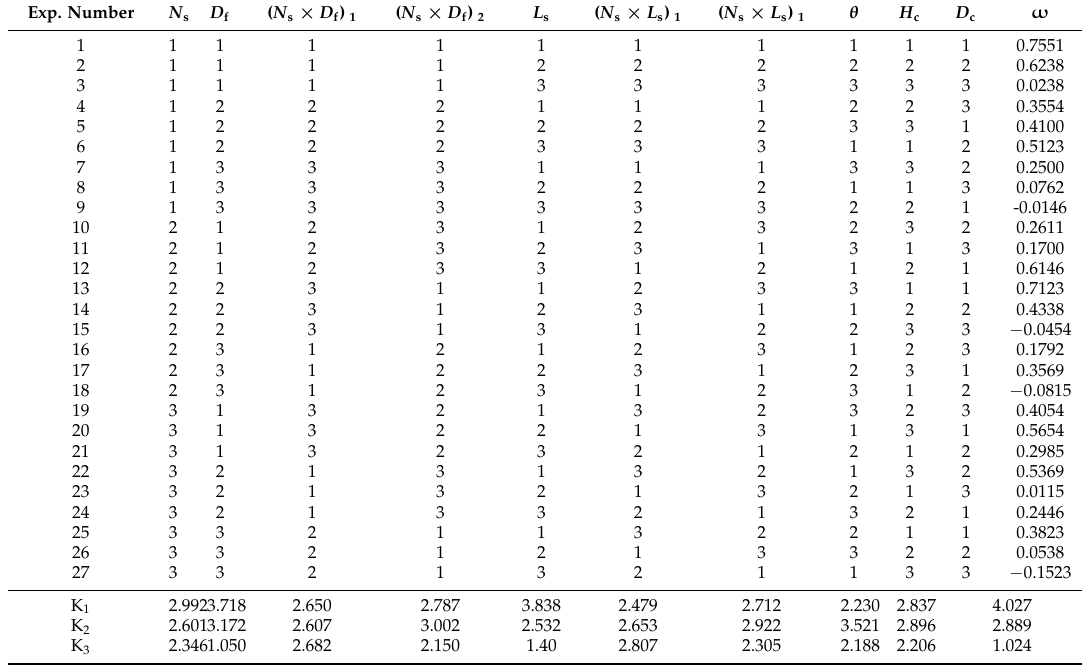
Table 2. Design matrix based on the L 27 (3 13 ) array and the experimental results. Exp.